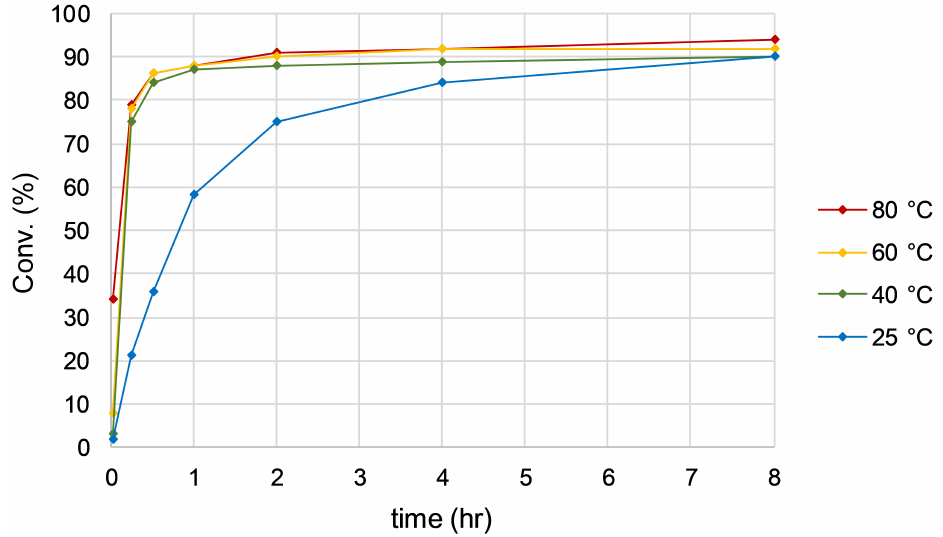
Figure 9. Conversion of acetophenone over time at various temperatures. All conversions appeared to level off after a period of 8 h.